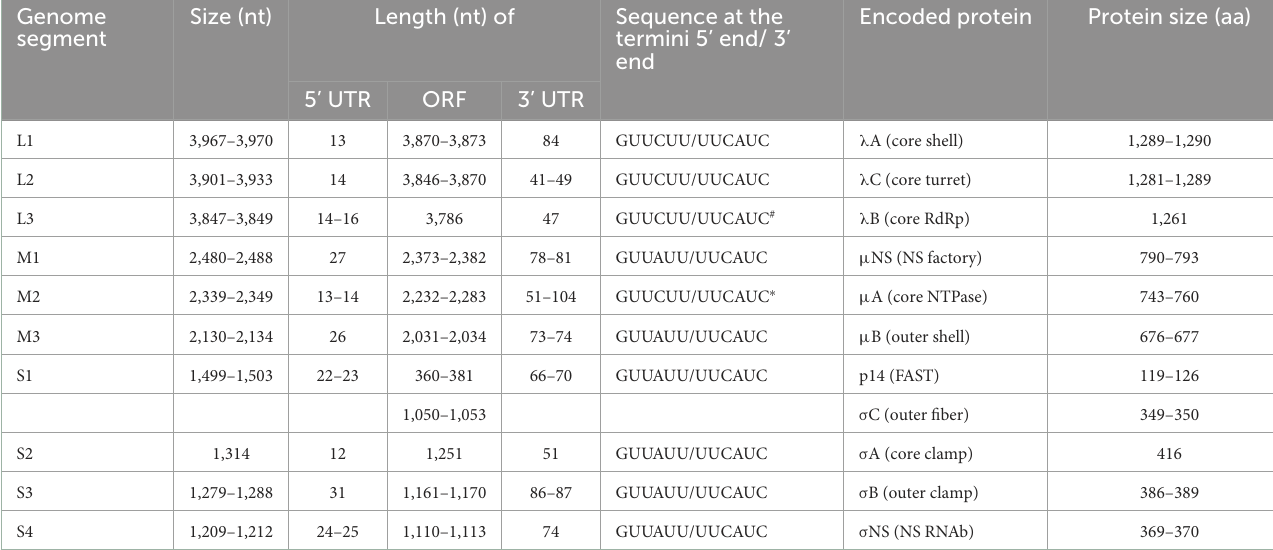
TABLE 2 General genomic features of the studied strains. Genome